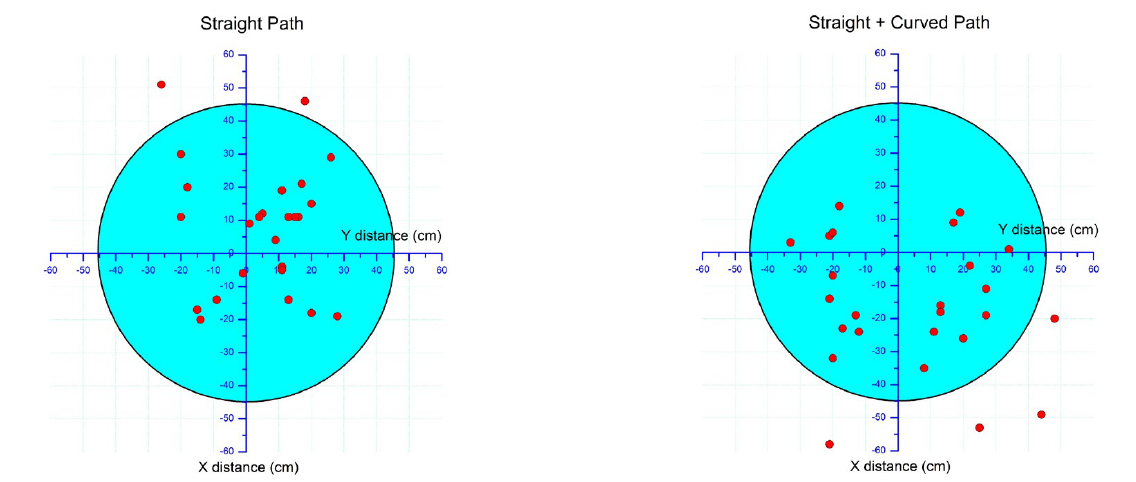
Figure 6. Movement performance result of the autonomous mobile robot. The red dot is the point where the robot arrived.